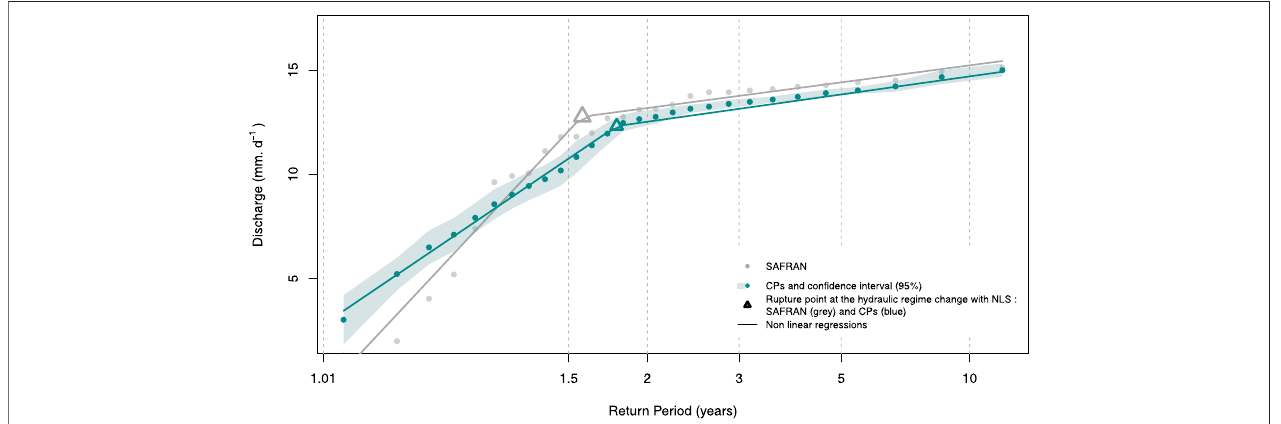
FIGURE4| Comparisonofthespeci fi cdischarges Q spe (heretheannualmaximaldischarge)associatedwithreturnperiodsRPsinthehistoricalperiod1975 – 2004 between those obtained from the CPs and those from the historical reference. The equation Q spe (cid:2) f ( RP ) was fi tted as a piecewise function (see Eq. 8 ) according to a non-linear regression, for both situations. The equation from the CPs was established from the mean of the distribution functions of the annual maximal discharge from the 12 CPs, supported by a con fi dence interval at 95%.